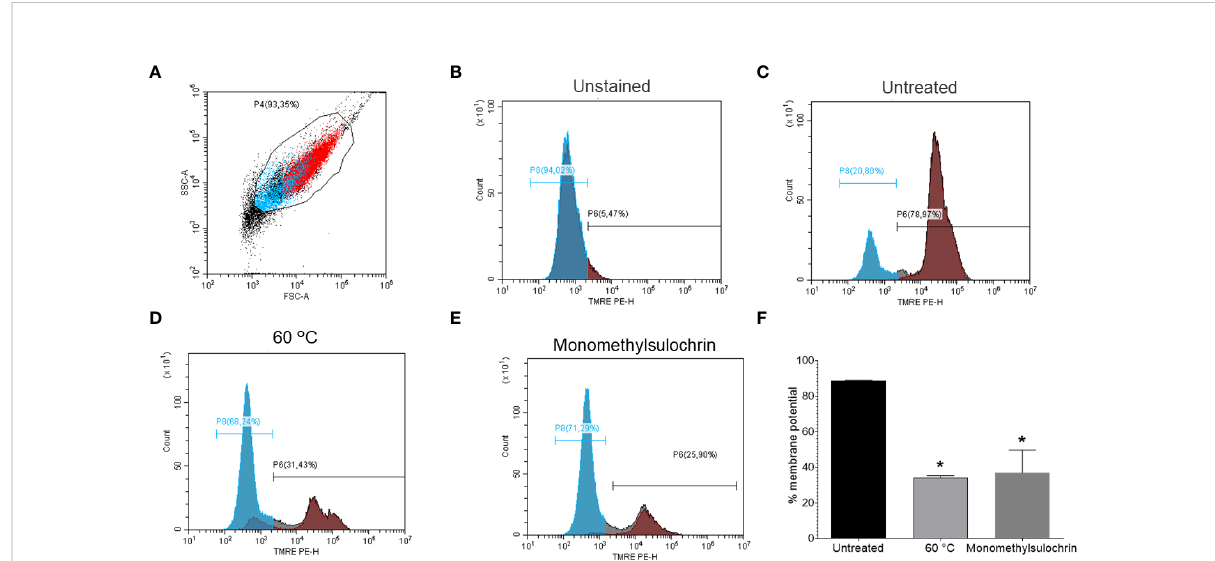
FIGURE 5 Flowcytometry ofpromastigote forms of Leishmania amazonensis mitochondrial membrane potential ( DY m)treated with monomethylsulochrin. (A) FSC versus SSC dotplot to de fi ne L.amazonensis -promastigotespopulation. (B) TMRE-staining histogram ofcontrol samples (unstained and untreated parasites), gated on “ promastigotes. ” (C) TMRE-staining histogram of monomethylsulochrin-untreated parasites. (D) L. amazonensis promastigotes killed by heat (60°C). (E) Representative histogram of L.amazonensis promastigotes treated with 18.04 m M ofmonomethylsulochrin. (F) Statistically signi fi cant differences wereobserved between the percentages ofcells marked with TMREin the untreated group and the groups treated with monomethylsulochrin, at the IC 50 concentration(18.04 m M). * p < 0.05, when compared with the untreated group by Mann – Whitney test. Images are representative oftwo independent experiments carried out at least in